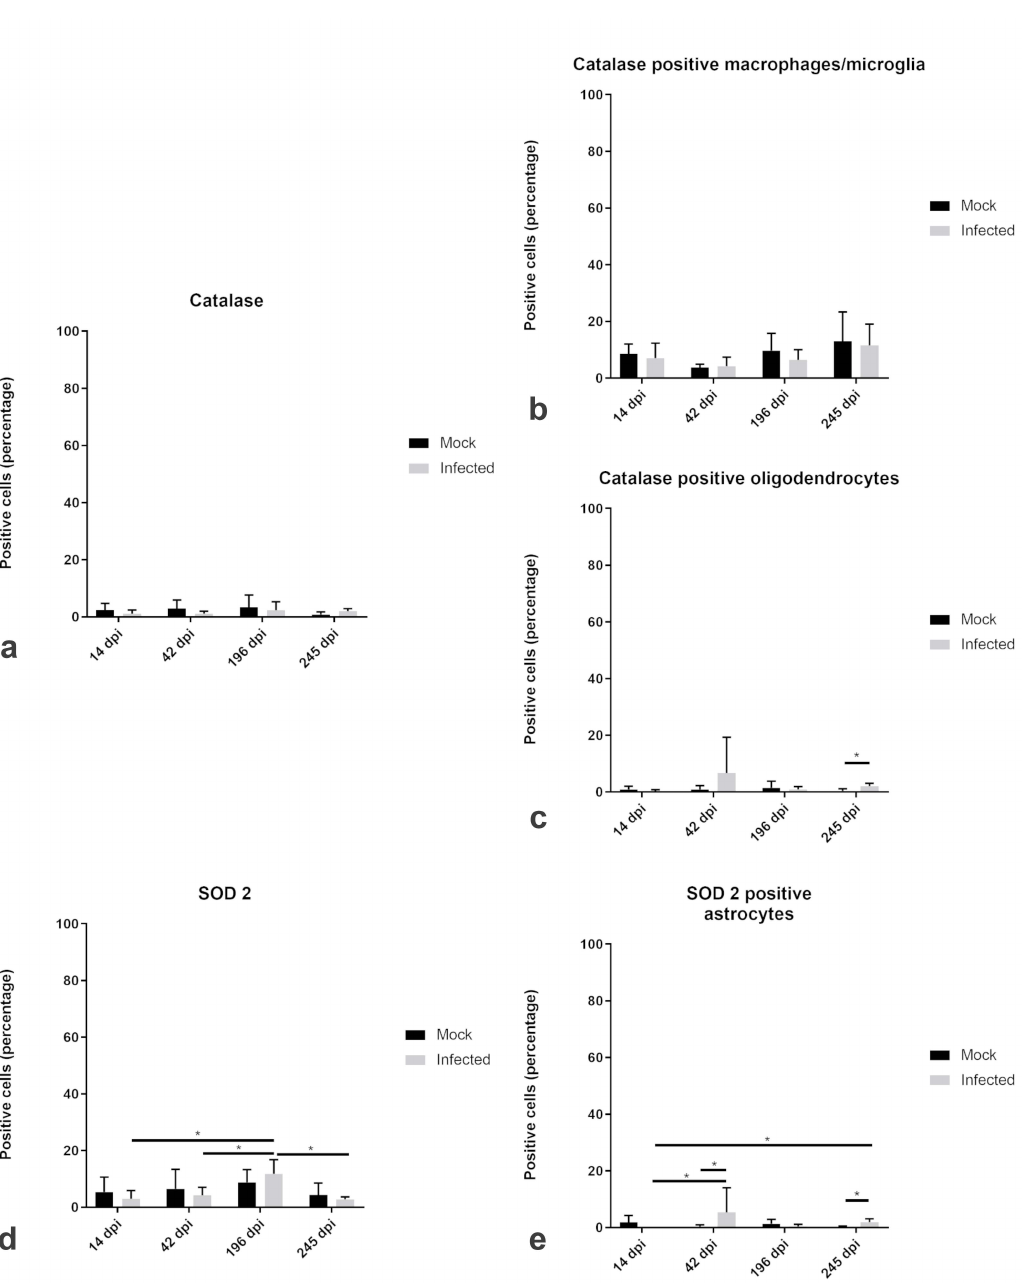
Figure 7. Antioxidant enzymes and colocalization with astrocytes, oligodendrocytes, and microglia / macrophages in the white matter of spinal cord of TMEV-infected mice. The box plots show percentage of positive cells for antioxidant enzymes (( a ) catalase and ( d ) SOD2) and the percentage of positive ( b ) macrophages / microglia, ( c ) oligodendrocytes and ( e ) astrocytes at day 14, 42, 196, and 245 dpi compared to mock animals. Significant di ff erences between the groups as revealed by the Kruskal–Wallis test with independent pairwise post-hoc Mann–Whitney U-test are marked with an asterisk (* p ≤